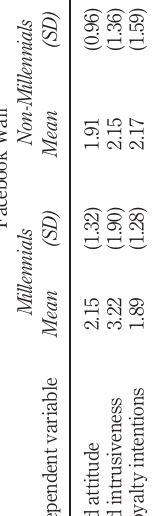
by social media format and